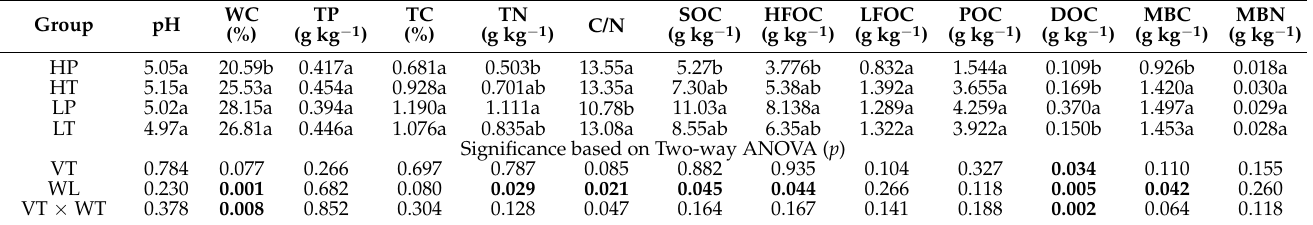
Table 1. Soil physicochemical properties and organic carbon characteristics in different